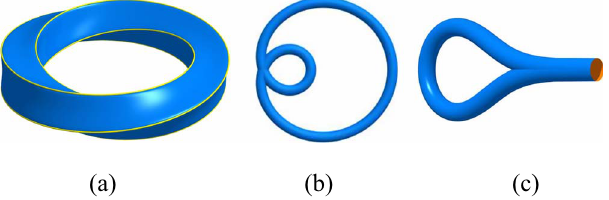
Figure 5. (a) GML 4 surface. (b) Torus with a Gielis curve with m = 1/2 as path. (c) A torus with path m = 1, giving rise to a Klein